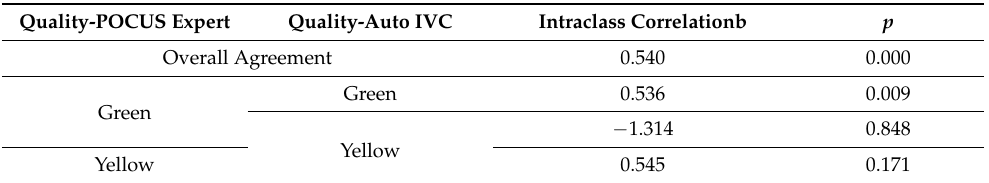
Table 3. IVC analysis—quality stratification and comparison between Auto LVOT-VTI tool and manual assessment by POCUS expert.